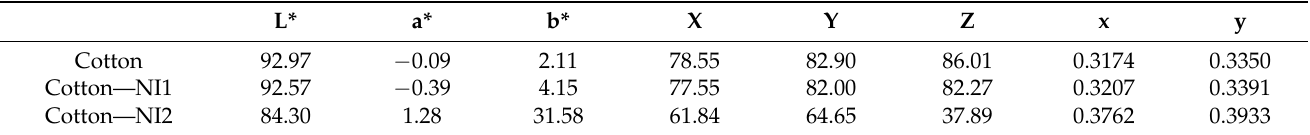
Table 4. Color characteristics of cotton fabric treated with NI1 and